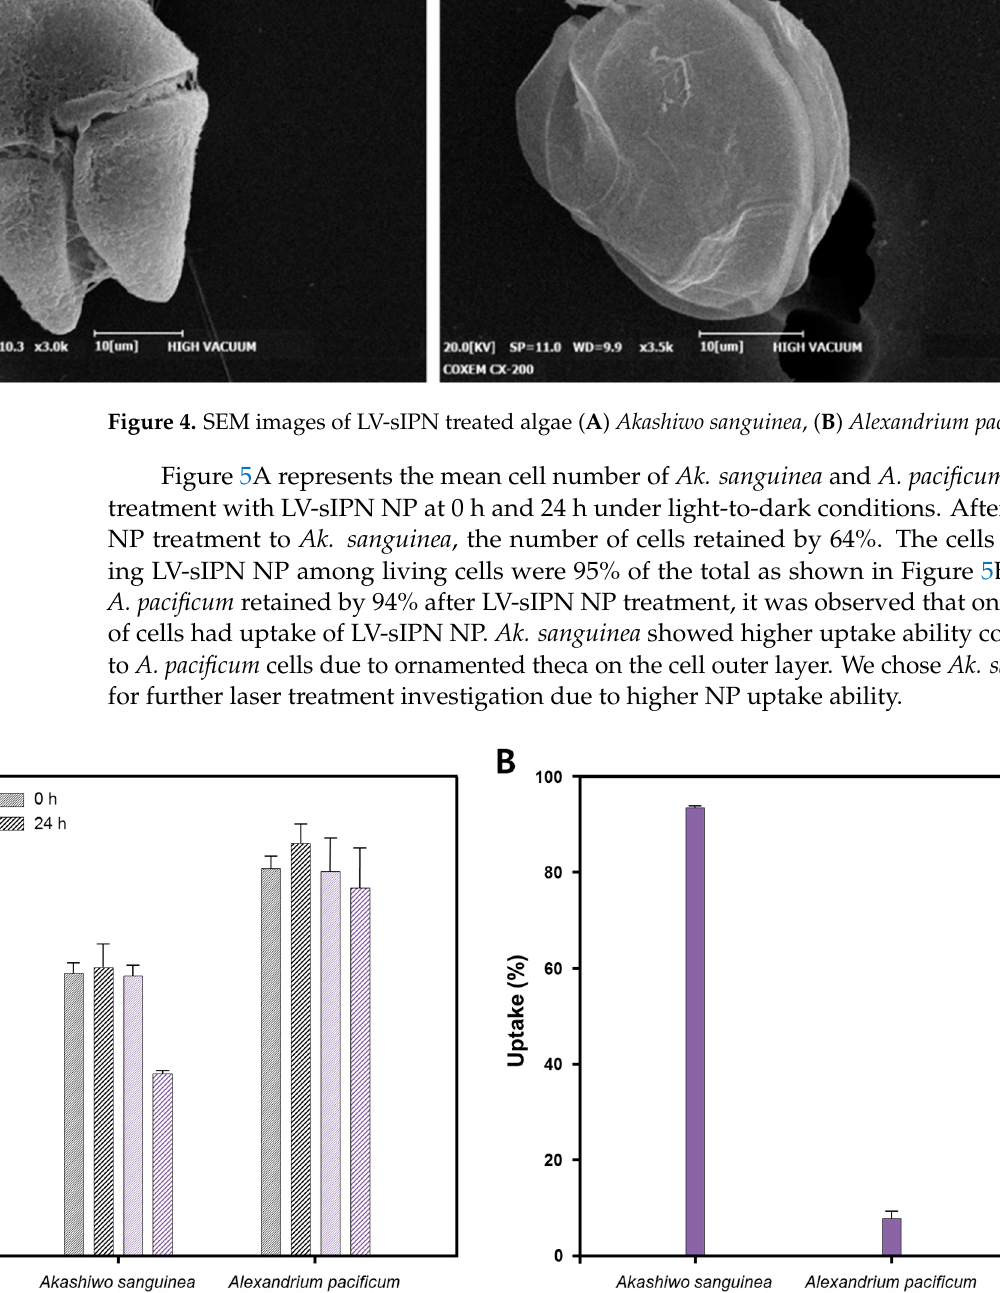
Figure 5. Monitoring the uptake for dinoflagellate species, Akashiwo sanguinea and Alexandrium pacificum , after 24 h of LV-sIPN NPs treatment. ( A ) Effect of LV-sIPN NPs on cell growth. It shows the change in the number of cells immediately after nanoparticle treatment (purple) and after 24 h (hatched purple). As a control, the number of untreated red-tide cells (grey) and the cell number after 24 h of incubation (hatched grey) were also observed. ( B ) Comparison of LV-sIPN NP uptake rate of dinoflagellate species after 24 h.